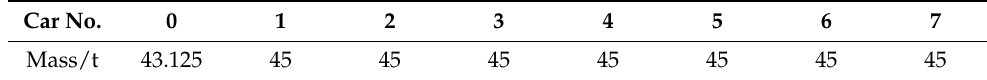
Figure 3. Dynamic collision model of vehicle system. Table 1. Vehicle mass distribution.